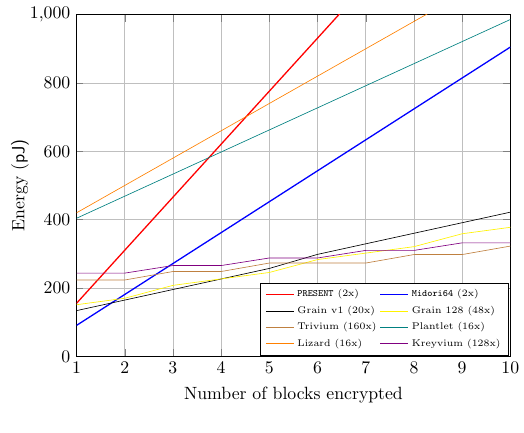
Figure 4: Energy consumptions for up to 10 blocks for most energy-efficient implementa-